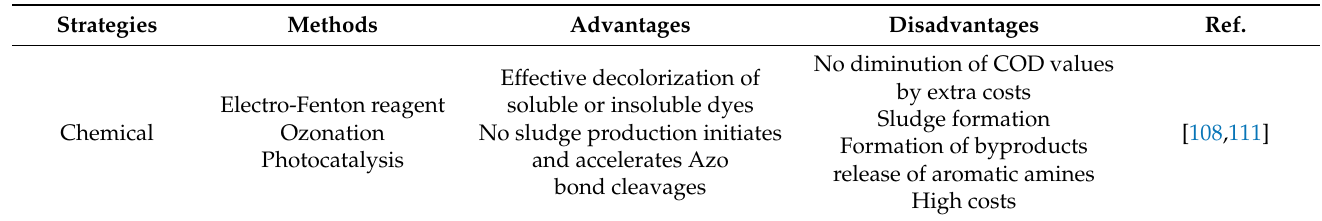
Table 3. Illustration of various methods for removal of organic